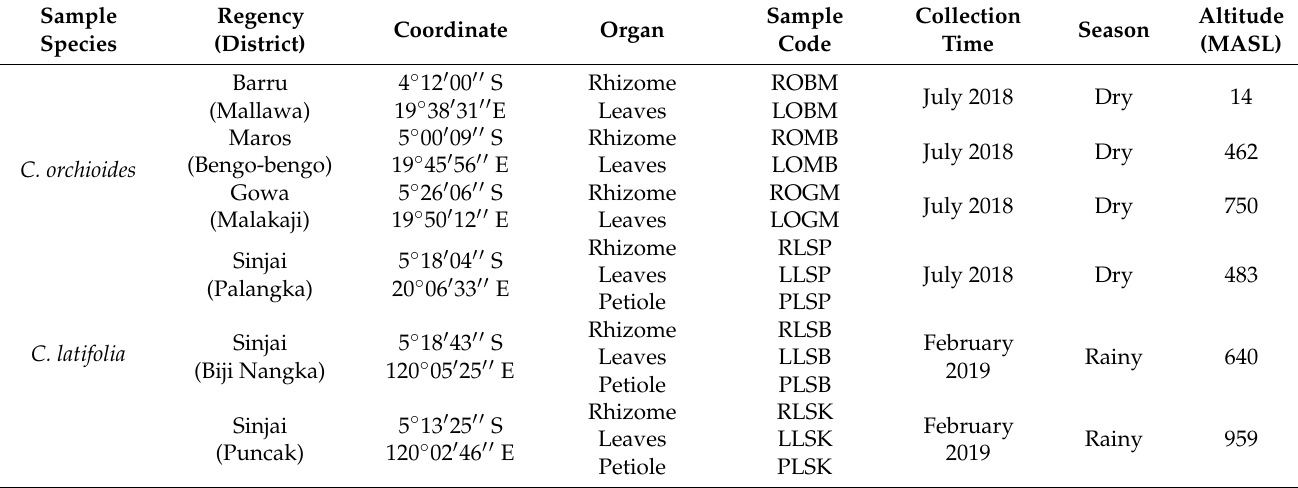
Table 1. Sources of plant samples in South Sulawesi.